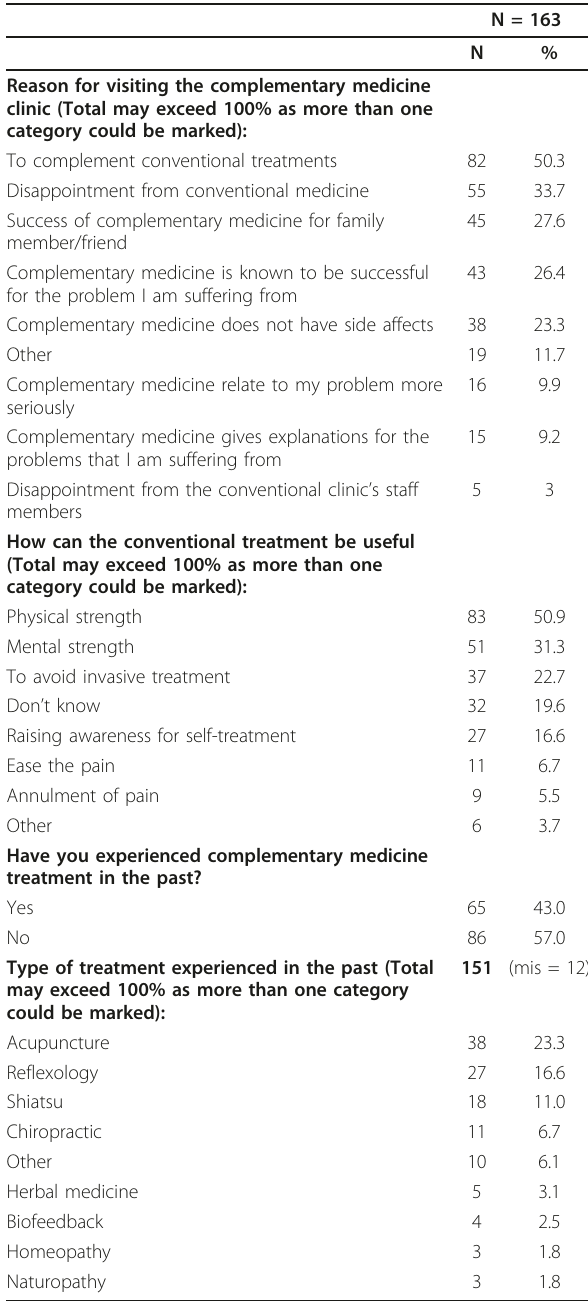
Table 4 Characteristics of Complementary Medicine